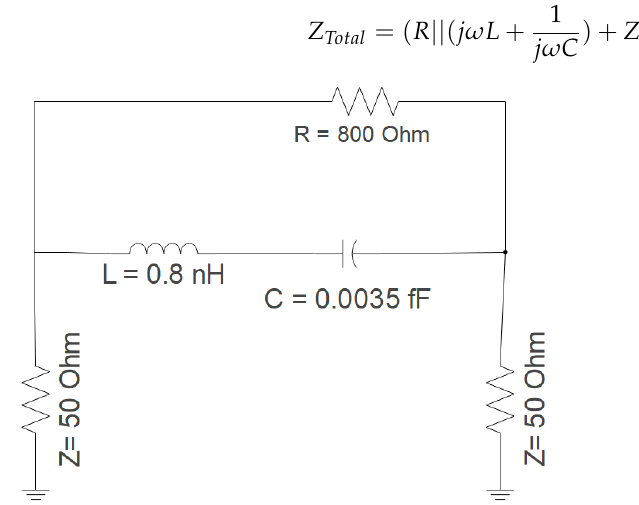
Figure 12. The equivalent circuit model of the proposed